Question: Draft a figure caption describing what is shown.
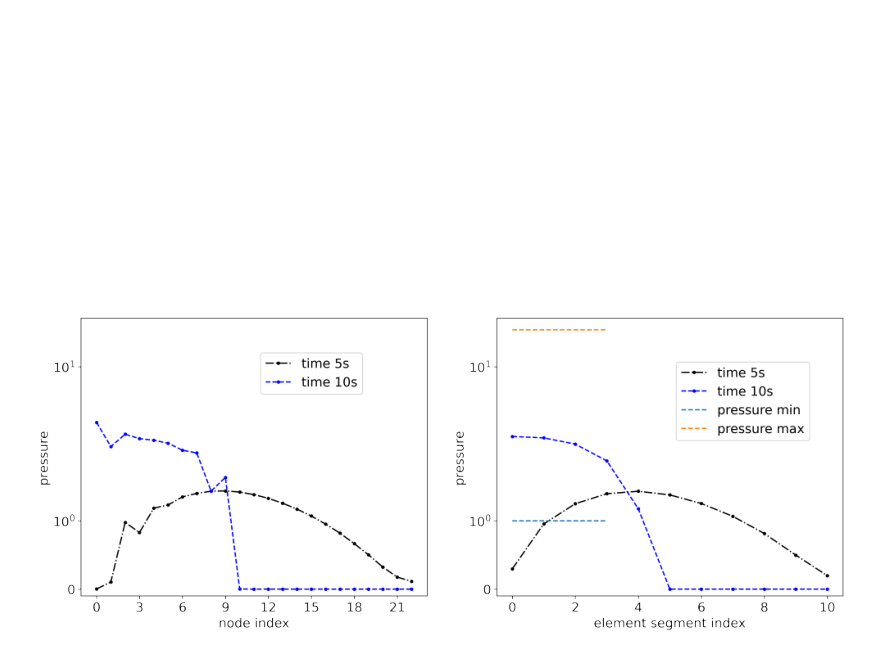
Answer: Pressure distribution on the contact surface for the initial design: nodal pressure (left) and averaged pressure on element segments (right).